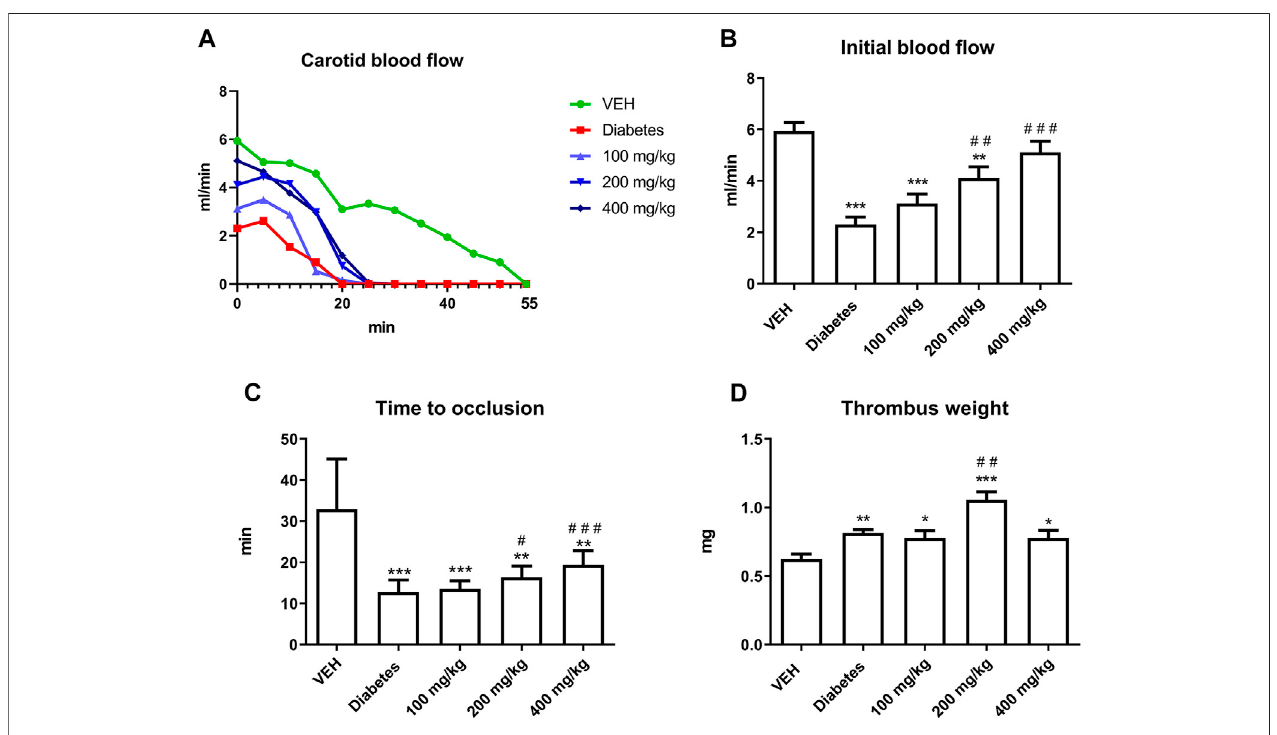
FIGURE 2 | The effect of TE on electrically induced thrombosis. Changes in the carotid blood fl ow in the artery of rats subjected to electrical stimulation (A) . The effect of TE on: IBF in the rat artery before electrical stimulation (B) , TTO in the rat artery (C) , dry thrombus weight (D) . * p < 0.05, ** p < 0.01, *** p < 0.001 vs. VEH; # p < 0.05, ## p < 0.01, ### p < 0.001 vs. Diabetes; n (cid:2) 8 – 11. Data are shown as mean ±